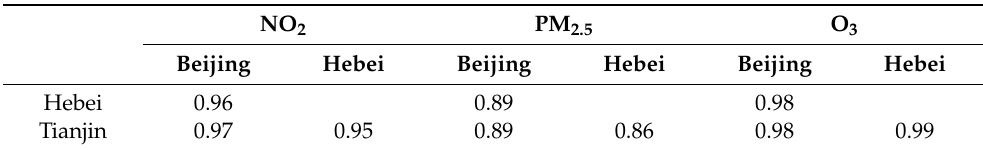
Figure 2. The distribution of the three air pollutant concentrations in Beijing, Tianjin and Hebei. Table 1. Pearson correlation coefficients of the time series of air pollution concentrations in Beijing, Tianjin and